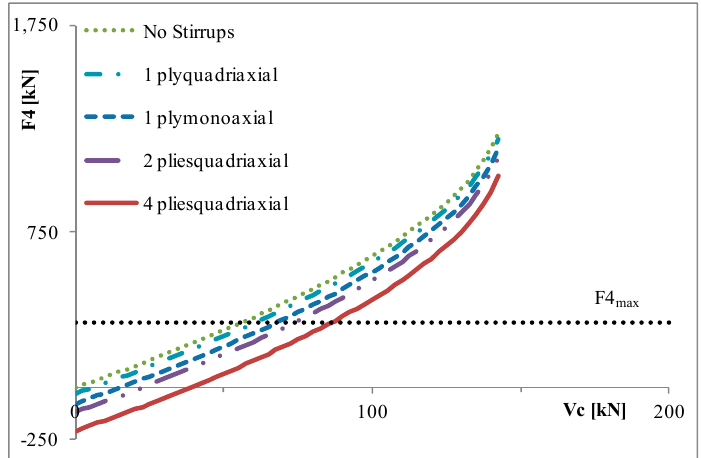
, in beam bars and its threshold with 4